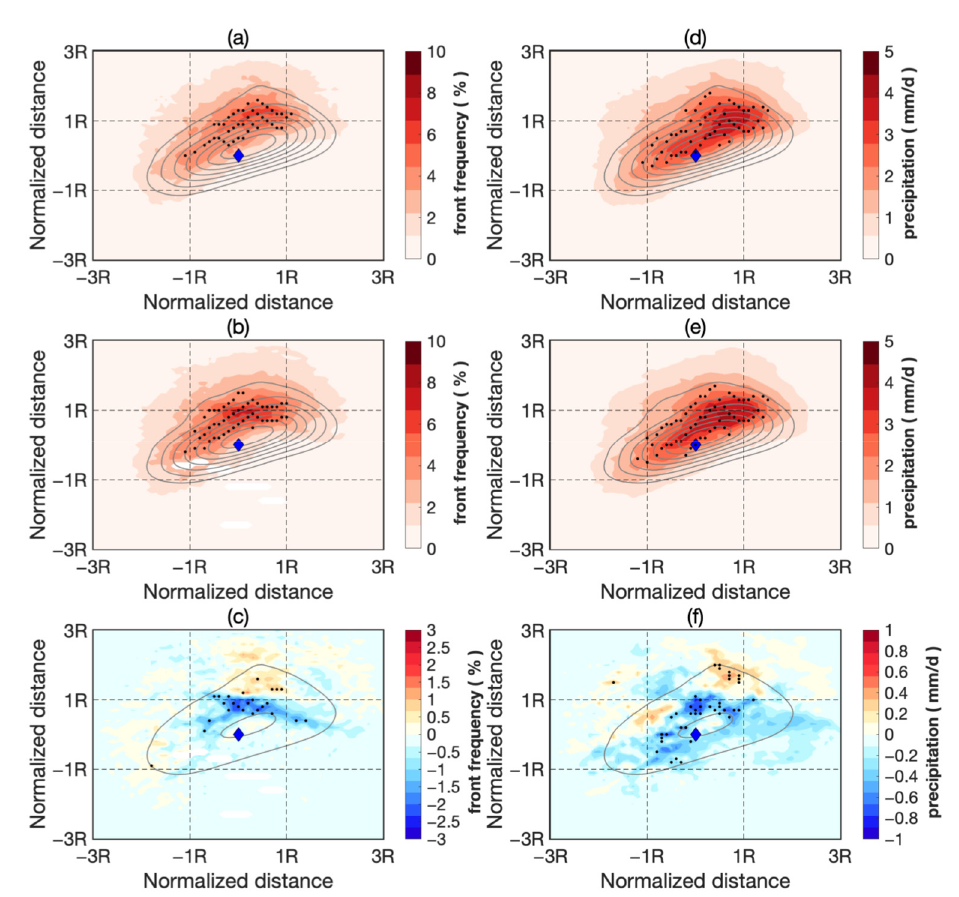
Figure 9. ( a ) Composite of atmospheric front frequency (color, %) and IVT (contour, kg m − 1 s − 1 ) in ARs during NAT+ phases. ( b ) Same as ( a ) but for NAT − phase. Contours are IVT (contour) in NAT+ phase from 50 to 350 with the interval of 50 kg m − 1 s − 1 . ( c ) Difference in front frequency (color) between NAT+ and NAT − phases. Contours are IVT of 50 and 350 kg m − 1 s − 1 showing the range and center of the AR in NAT+ phase. The black dots mark those above 95% confidence level based on a Student’s t -test. Right column( d – f ) is same as the left but for AR-related precipitation (mm/d). The blue diamond in each sub-figure marks the center of the